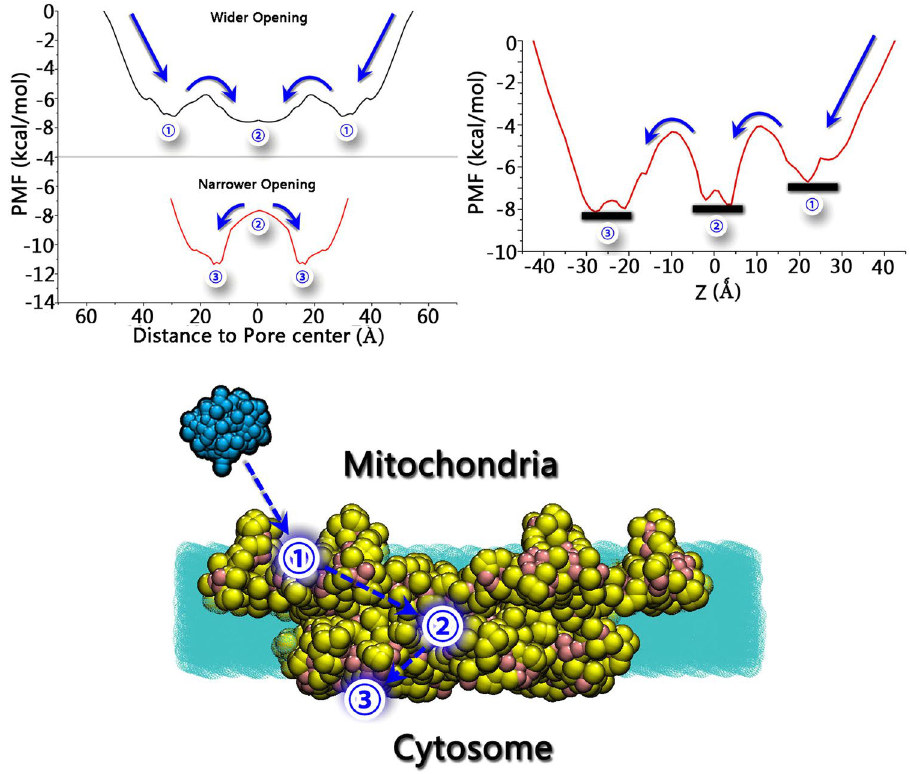
Figure 4. One-dimensional (1D) potential mean force (PMF) profiles along with xy distance and z axis (top), and the schematic diagram illustrating the release pathway of cytochrome C through Bax oligomeric pores. The red plateaus in the Fig. 3 were taken as the energy references (zero energy), since the sampling in red plateaus equals to zero. Thus, the zero energy appeared at z = − 40 or 40 and XY = 55. Color code: cytochrome C (cyan), Bax oligomeric pores (yellow and pink), and membranes (green). ① denotes the Bax areas at 25 Ǻ < xy < 40 Ǻ and 15 Ǻ < z < 30 Ǻ. ① denotes the Bax areas at 0 Ǻ < xy < 10 Ǻ and − 5 Ǻ < z < 5 Ǻ. ① denotes the Bax areas at 10 Ǻ < xy < 25 Ǻ and − 30 Ǻ < z < − 20